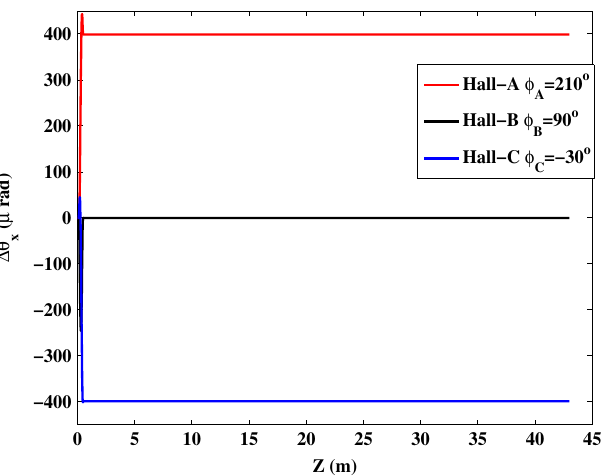
FIG. 11. Evolution of vertical deflection corresponding to rf phases (cid:4) A;B;C and deflecting voltage V def ¼ 5 : 06 MV .